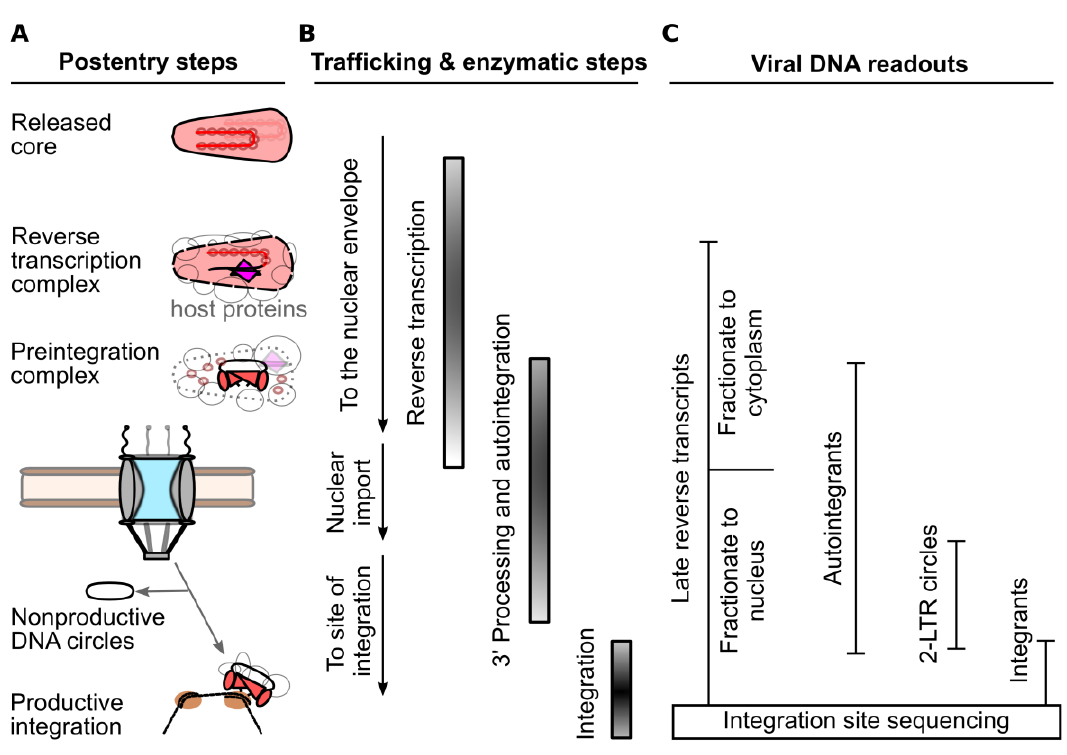
Figure 2. PCR-based methods for detection of post-entry to viral DNA integration steps of HIV-1 infection. (A) Generalized replication intermediates and byproducts leading up to integration. (B) Order of viral trafficking and RT and IN enzymatic steps. (C) Summary of viral DNA species that serve as markers for the various infection intermediates and